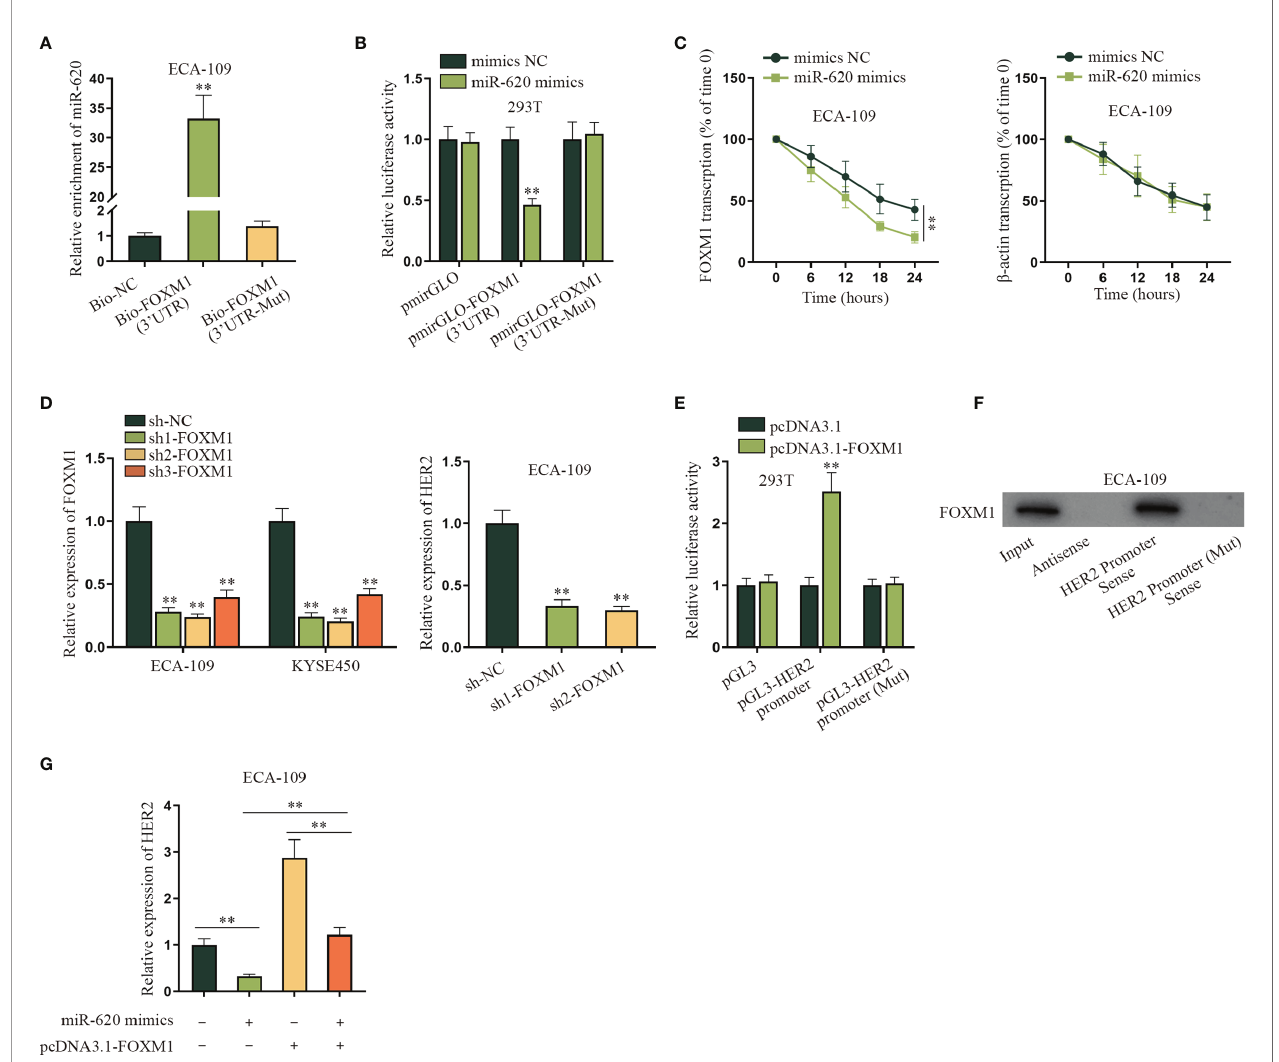
FIGURE 3 | MiR-620 regulates HER2 expression through FOXM1. (A) RNA pull-down assay with qRT-PCR was adopted to detect the enrichment of miR-620 in Bio-FOXM1 (3 ′ UTR) group in ECA-109 cells. (B) Luciferase reporter assay was conducted to test the luciferase activity of HEK293T cells transfected with miR-620 mimics in pmirGLO-FOXM1 (3 ′ UTR) group. (C) A total of 50 mM a -amanitin was used to treat ECA-109 cells, and qRT-PCR was used to examine the stability of FOXM1 mRNA upon miR-620 upregulation. (D) FOXM1 expression was reduced in ECA-109 cells, and the expression of HER2 upon FOXM1 inhibition was tested by qRT-PCR. (E) Luciferase reporter assay was conducted to detect the luciferase activity of HEK293T cells transfected with pcDNA3.1-FOXM1 in pGL3-HER2 promoter group. (F) RNA pull-down assay with Western blot was carried out to evaluate the enrichment of FOXM1 pulled down by HER2 promoter antibody. (G) qRT-PCR was used to examine the expression of HER2 in ECA-109 cells upon different transfection treatments. ** p <